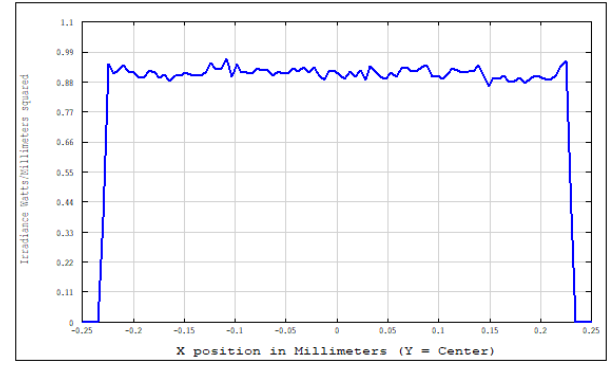
Figure 9. Light-field-intensity distribution in the X-direction.